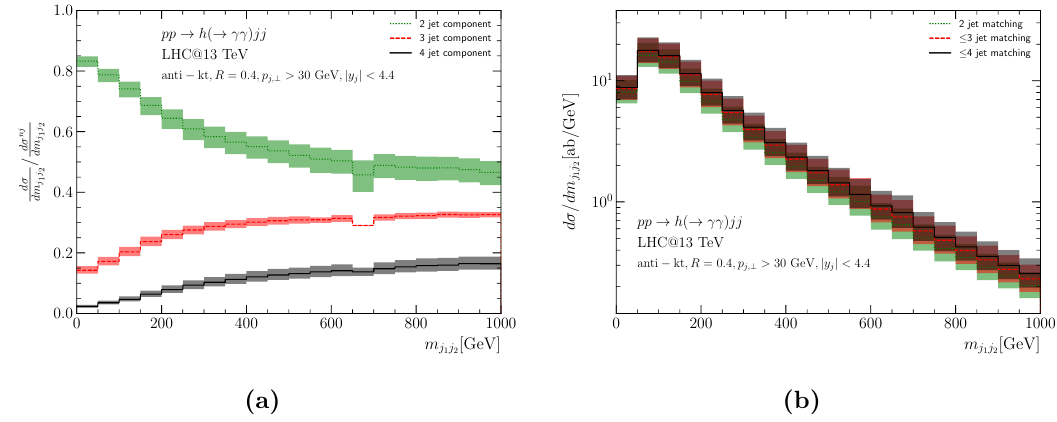
Figure 7. Distribution of the invariant mass between the hardest jets. Panel (a) shows the fractional contributions from exclusive two-, three-, and four-jet events. Panel (b) depicts the e(cid:11)ects of (cid:12)xed-order matching up to two, three, and four